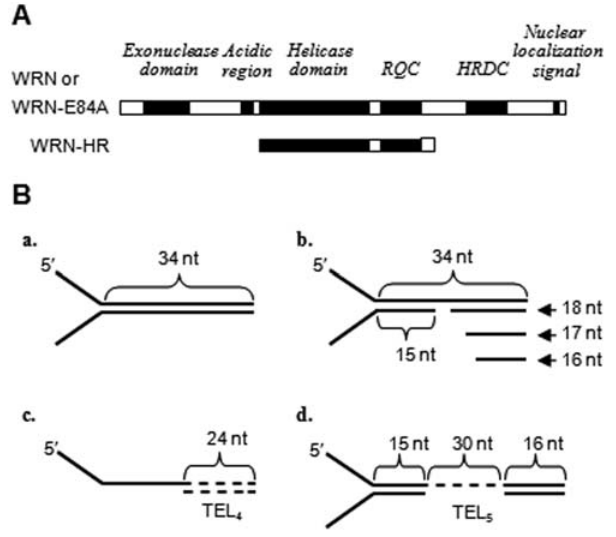
Figure 1. A schematic diagram of recombinant proteins and DNA substrates. (A) The modulations of active helicases were studied using WRN variants. WRN-E84A is a full-length WRN with the N-terminal exonuclease inactivating mutation at E84 to alanine. WRN-HR is a WRN fragment containing helicase and RQC domains. (B) All DNA substrates contained 5 9 -10-nt poly-T tails while 3 9 -10-nt poly-T tails were excluded only in few of the indicated experiments. [a] Fork substrate without gap. [b] Fork substrate with 1 to 3-nt gap. [c] Fork substrate with 4 telomeric repeats located in the duplex DNA following 3-nt gap. [d] Fork substrate with 5 telomeric repeats located in ssDNA of the non- translocating strand.